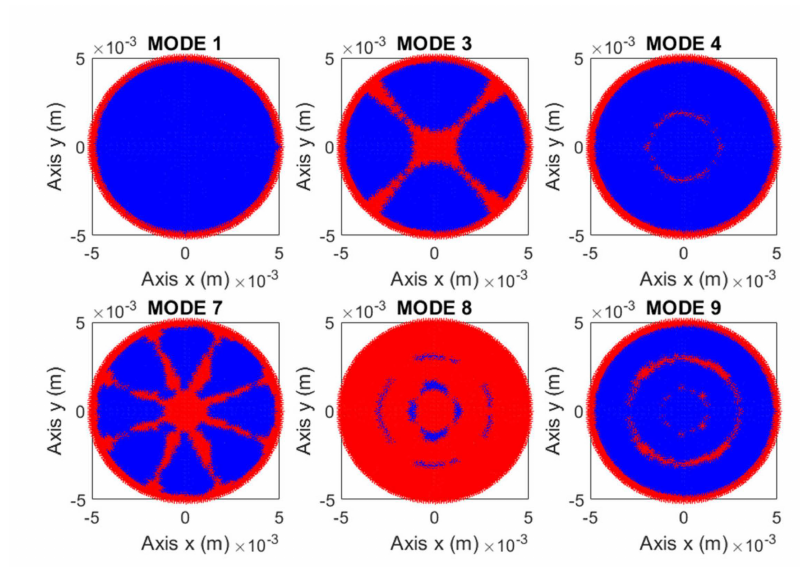
Figure 7. Candidate points from the surface of the membrane for a membrane with a thickness of 40 microns and with an angle of 90 ◦ . Modes 1, 3, 4, 7, 8 and